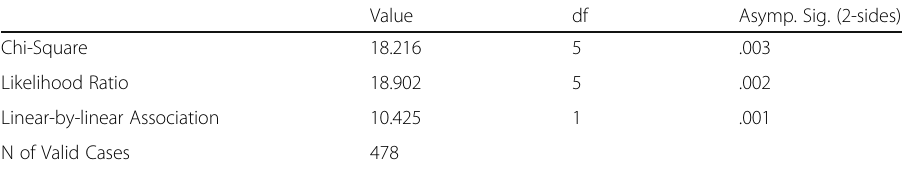
Table 3 Results of Chi-Square Tests for Different Types of EWs Used in English and Persian Short Stories Value df Asymp. Sig. (2-sides) Chi-Square 18.216 5 .003 Likelihood Ratio 18.902 5 .002 Linear-by-linear Association 10.425 1 .001 N of Valid Cases